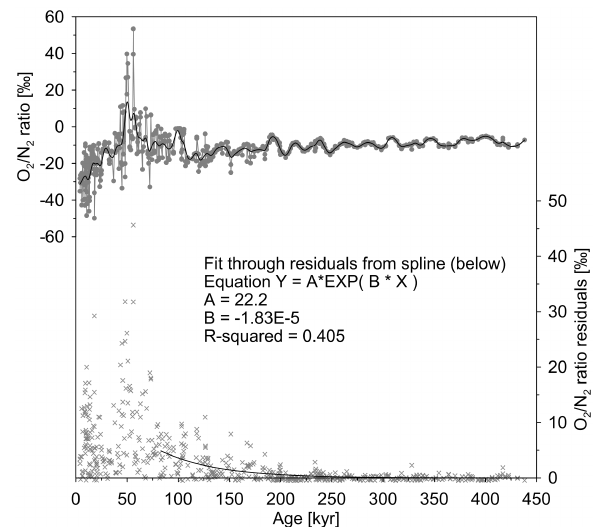
Fig. 3. Top: O 2 /N 2 ratio data from the Vostok ice core (Bender, 618 2002) (grey dots) and the data spline with a cut-off frequency of 11kyr (Enting, 1987) (black line). Bottom: residuals of the O 2 /N 2 ratio values relative the the spline (grey crosses) and the exponential fit through the residuals older than 83kyr (black line). The text in the middle of the figure shows the fit